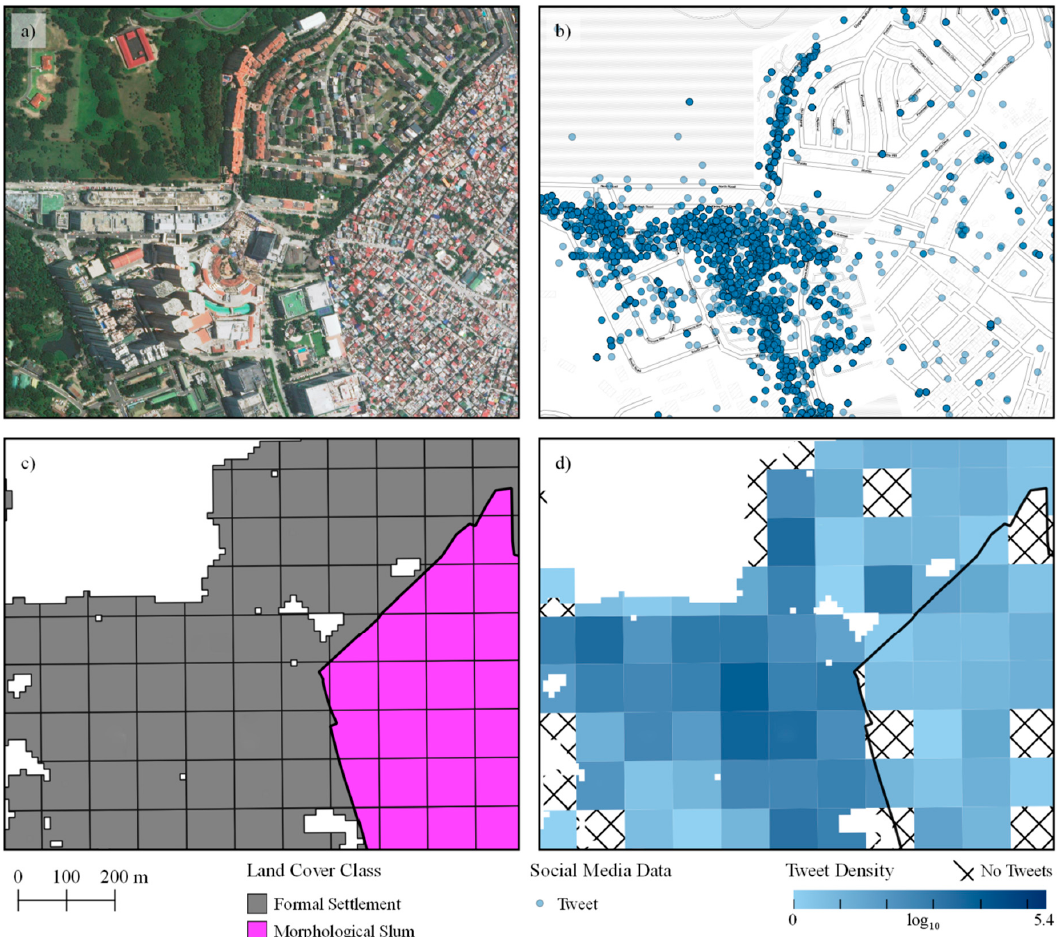
Figure 2. Illustrations of input data processing steps for a subset of Manila: ( a ) very high resolution (VHR) satellite data © ESRI; ( b ) Geolocated tweets for an 11-month time period and base map from STAMEN/OSM; ( c ) Classification of the economic divide by urban morphology characteristics into ‘morphologic slum’ and ‘formal settlement’ and ( d ) Tweet density aggregated onto a regular grid of 100 × 100m.